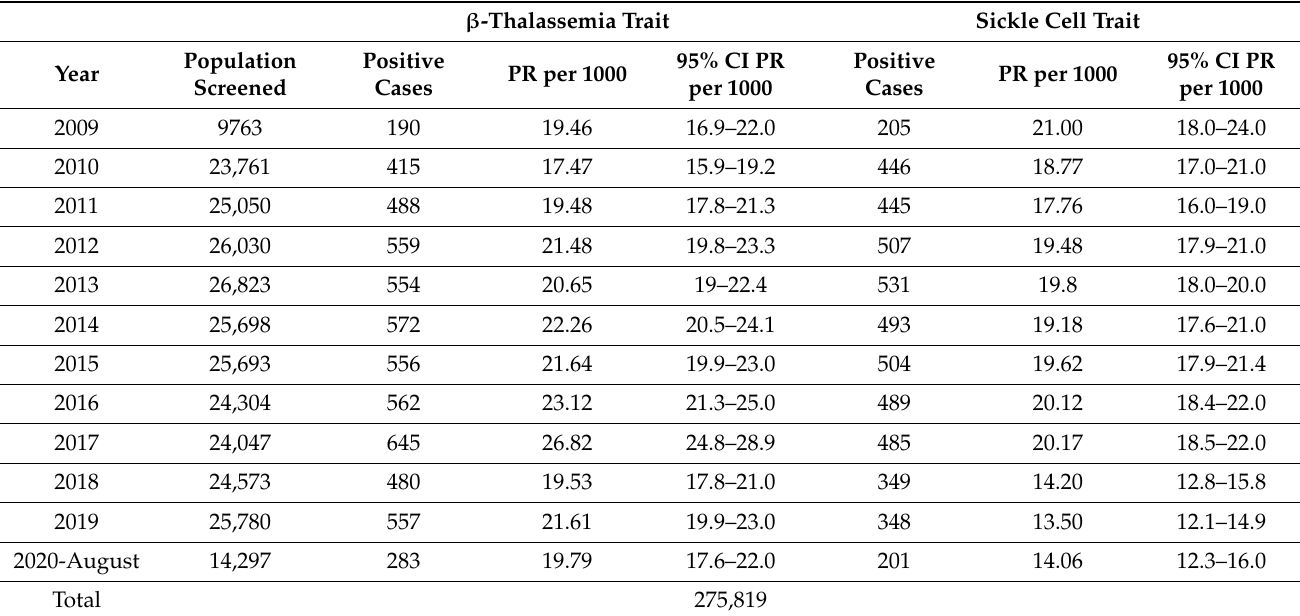
Table 2. The average prevalence rate per 1000 for β -thal and Sickle cell trait among the screened population. β -Thalassemia Trait Sickle Cell